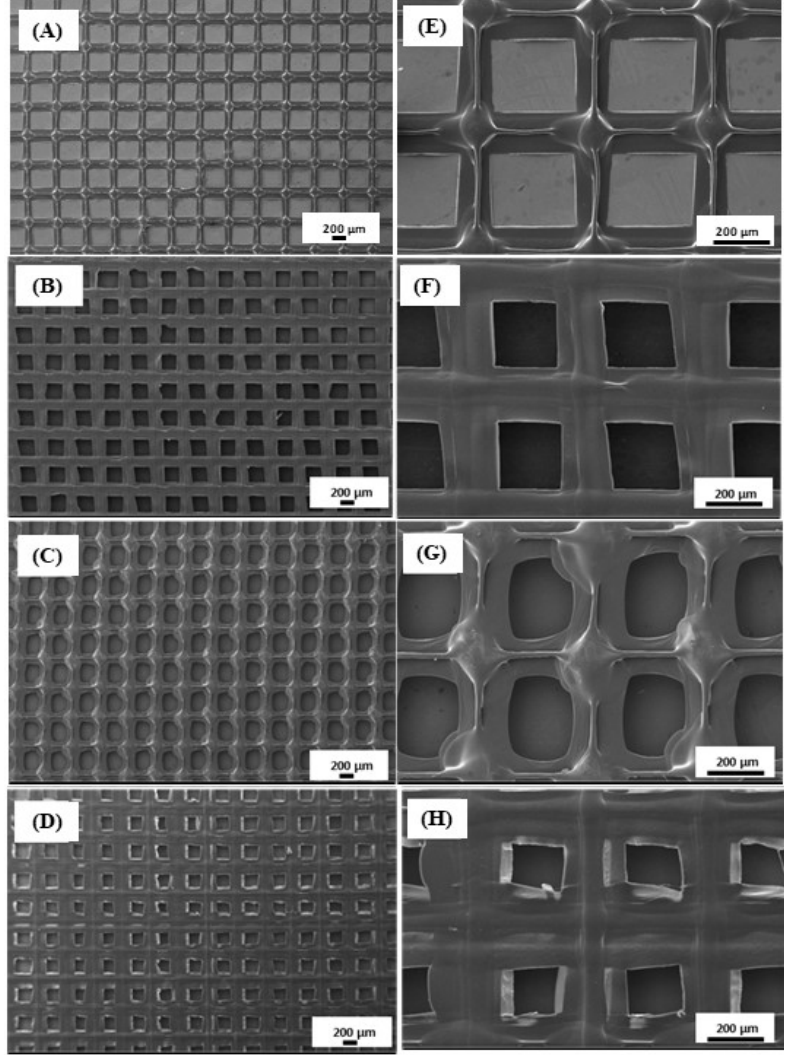
Figure 2. Scanning electron microscopy (SEM) images of the morphology of the scaffolds: PCL/PVA ( A , E ), PCL/PVA/PCL ( B , F ), PCL/PVA-Met ( C , G ), and PCL/PVA-Met/PCL ( D , H ).